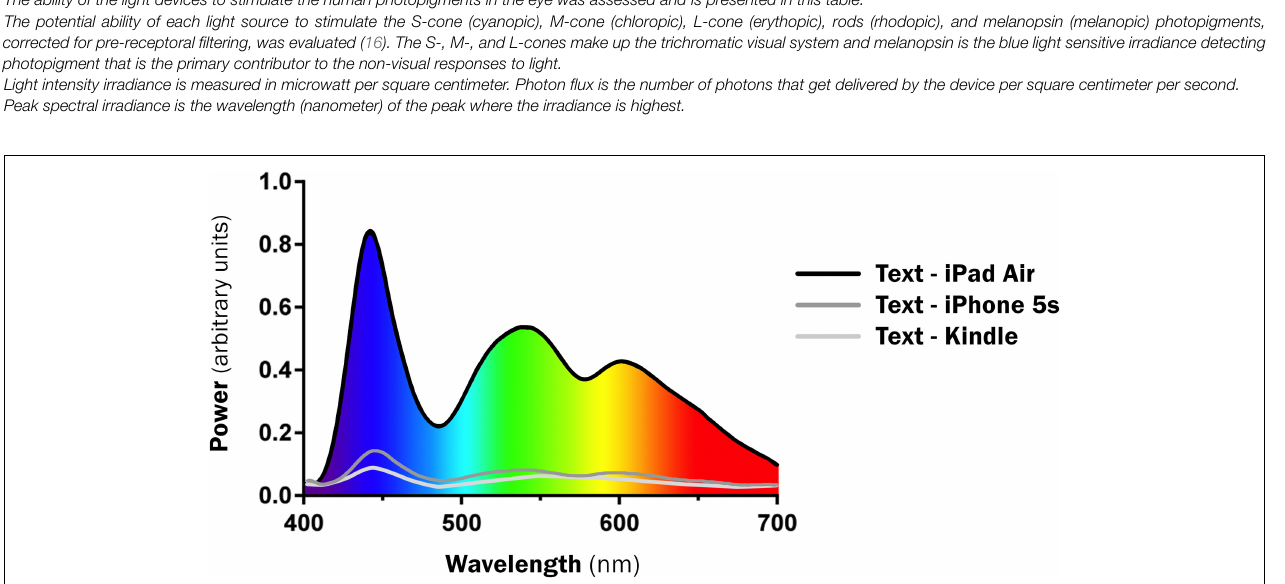
FIGURE 1 | Spectral Profile comparing identical text on all three devices